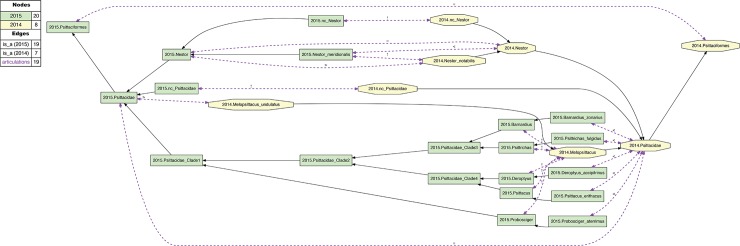
Input visualization for the 2015./2014.Psittaciformes alignment, with coverage locally relaxed.Compare with Fig 1. Here, coverage is relaxed for two family-level concepts (2015./2014.nc_Pittacidae) and two genus-level concepts (2015./2014.nc_Nestor). The eight species-level concepts of the alignment are correspondingly included as members of these higher-level concepts. In addition, three instances of congruence are asserted for 2015./2014.{Psittaciformes, Psittacidae, Nestor}. See also S3 File.